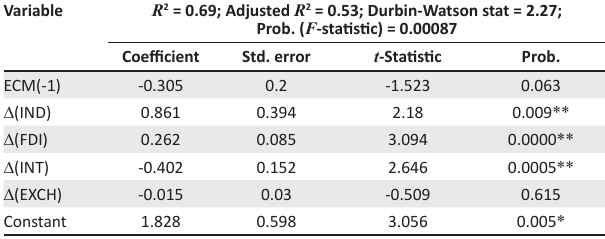
TABLE 4: Pairwise Granger causality tests. Null hypothesis Direction Observation F -stats.